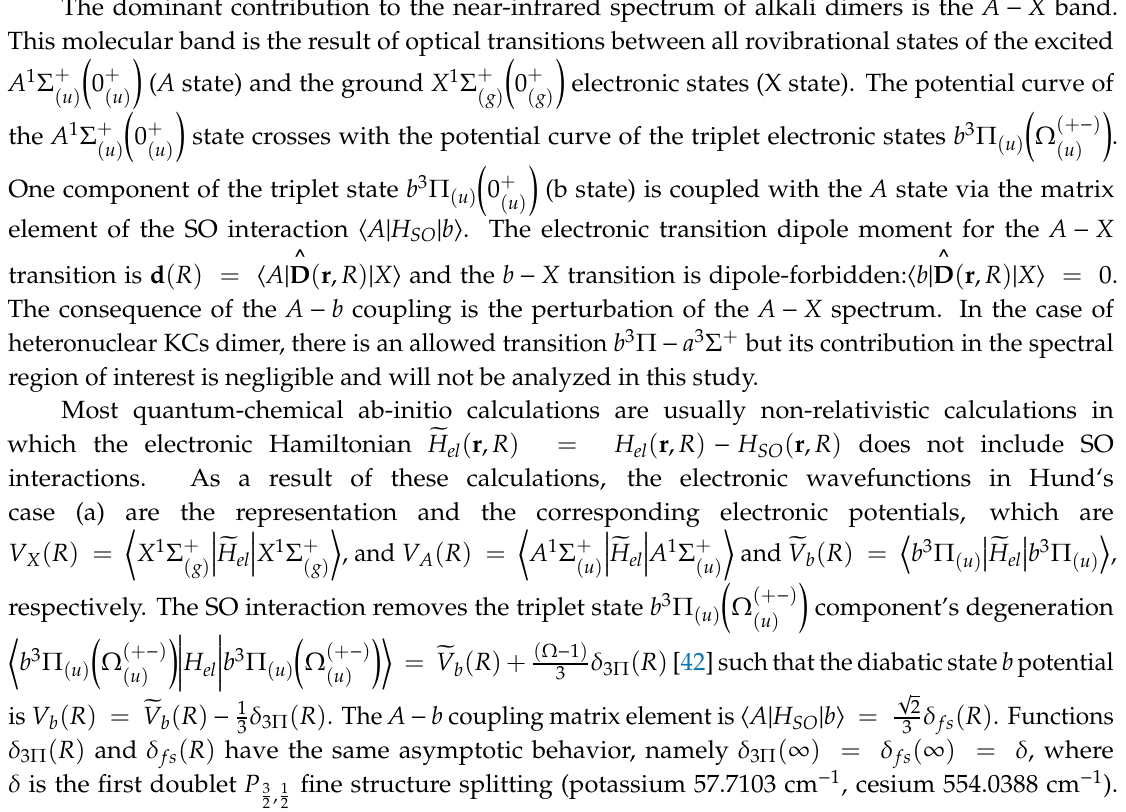
state crosses with the potential curve of the triplet electronic states b 3 Π ( u